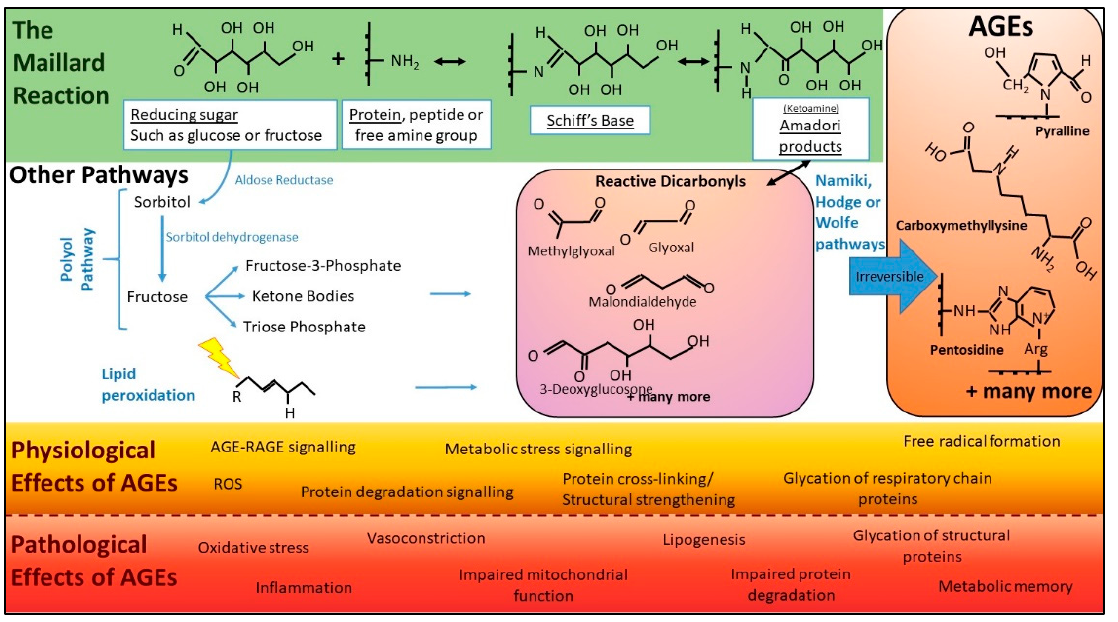
Figure 1. Basic pathways of AGE chemistry and associated physiology and pathology. In the classical Maillard reaction (green), AGEs are formed when reducing sugars and proteins interact. Initially, reaction intermediates termed Schiff bases are formed. These subsequently rearrange into ketoamines known as Amadori products or early glycation products. These are more stable products than Schiff bases but, at this point in the reaction, the chemistry is still reversible. After further chemistry, the reaction becomes irreversible and forms AGEs (orange). There are several other cellular pathways, including the polyol pathway (shown) and lipid peroxidation (where oxidants, such as free radicals, “attack” (lightning bolt) lipids that contain carbon-carbon double bonds), that can lead to the formation of reactive dicarbonyls, “termed carbonyl stress” (purple) rapidly accelerating the formation of AGEs. Beyond proteins, lipids and DNA can also undergo glycation, leading to AGEs. Pathways such as the polyol pathway only occur inside the body. AGEs have both physiological roles (orange) and pathological effects (red). (Abbreviations: AGEs, advanced glycation end products; ROS, reactive oxygen species).